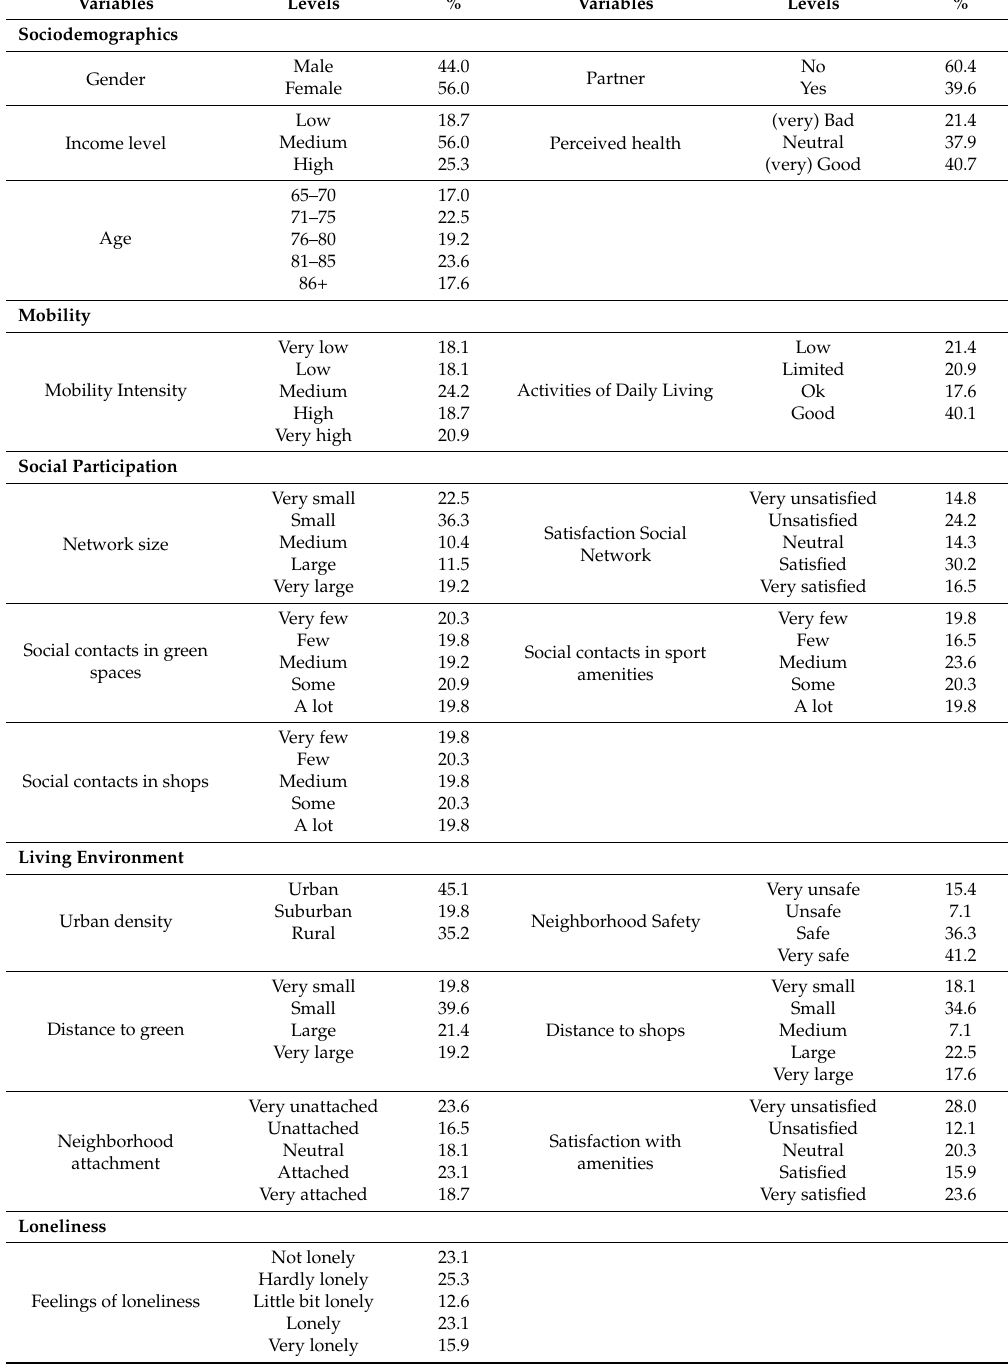
Table 7. Variables used in the Bayesian network model analysis (N =